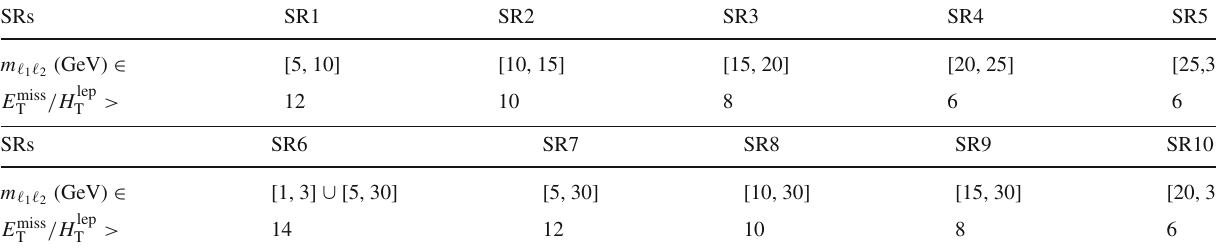
/ H lep of the signal and background events at the HE-LHC. The benchmark point is T T = 471 GeV ˜ χ 0 1 / H lep T